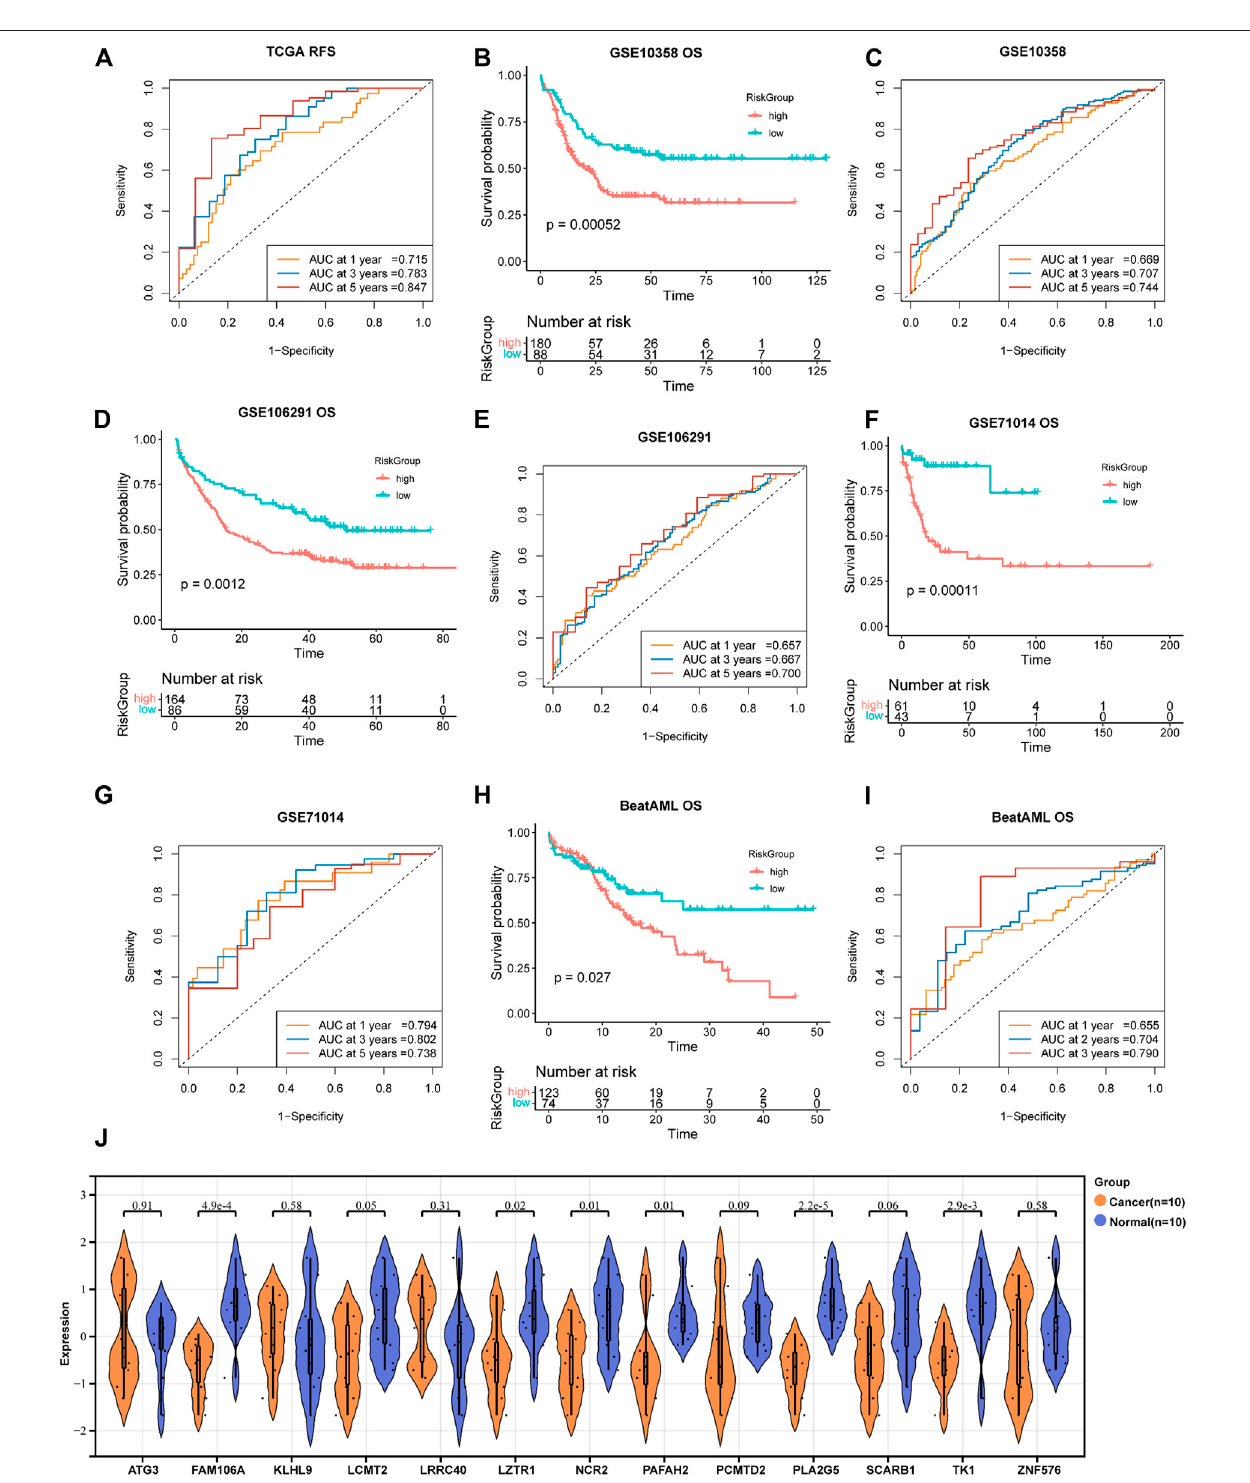
FIGURE5| Validationofthe13-geneprognosticsignatureindifferentdatasets. (A , B) RFSanalysisandROCoftheriskgroupinTCGAdataset.Reciprocalsurvival analysisand ROC ofGSE71014 (C , D) , GSE106291 (E , F) ,and BeatAML (G , H) datasets wereillustrated. 5IROCofGSE10358 survivalanalysis displayed in Figure 4K . (J) RT-PCR-detected RNA expression of 13 genes in our own samples, 10 AML de novo , and 10 IDA as normal control samples.